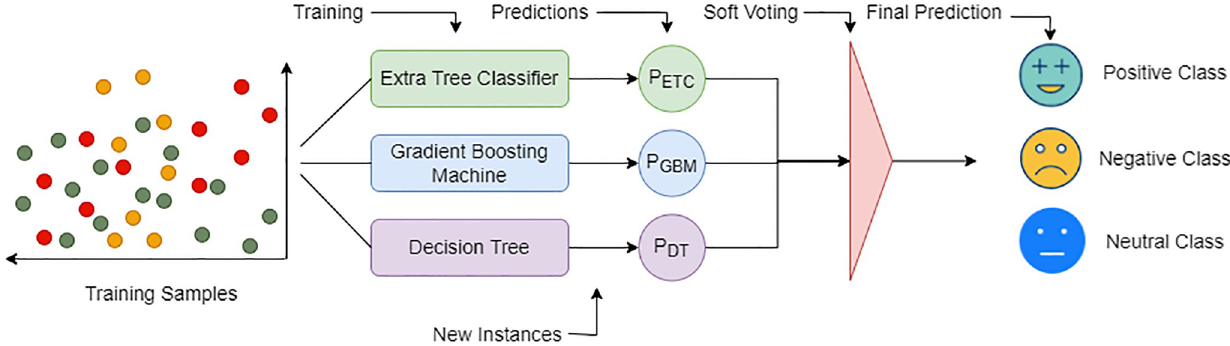
Fig 4. Architecture of proposed EB-DT voting